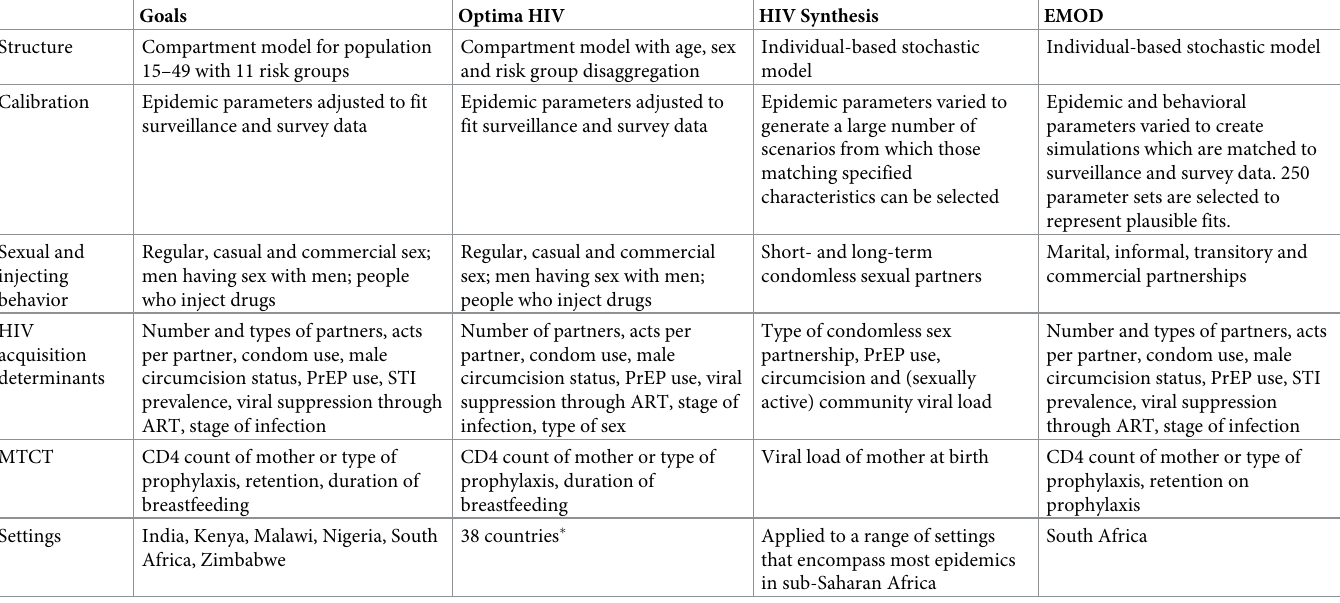
Table 1. Key characteristics of the HIV